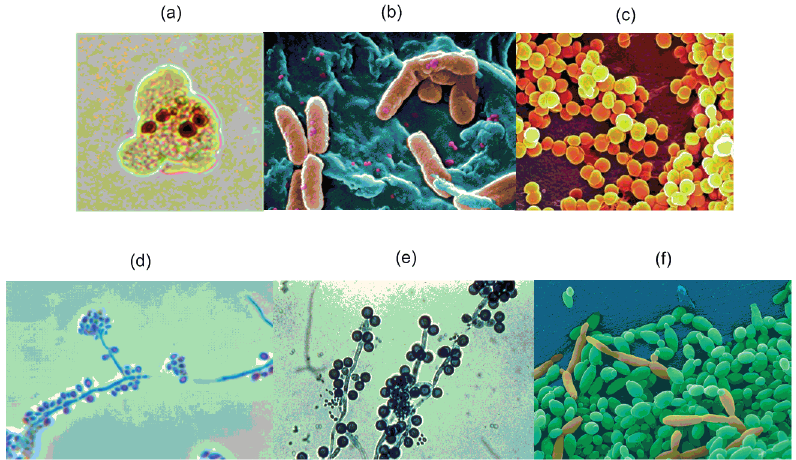
Figure 1. ( a ) Entamoeba histolytica ; ( b ) Pseudomonas aeruginosa ; ( c ) Staphylococcus aureus , ( d ) Sporothrix schenckii ; ( e ) Candida albicans ; and ( f ) Candida tropicalis